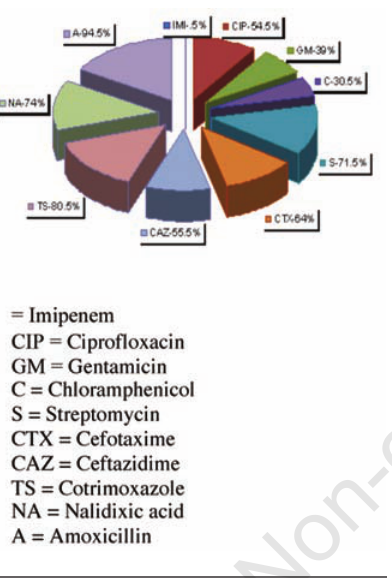
Figure 2. Pattern of resistance among 200 E. coli isolates to 10 antimicrobial agents.